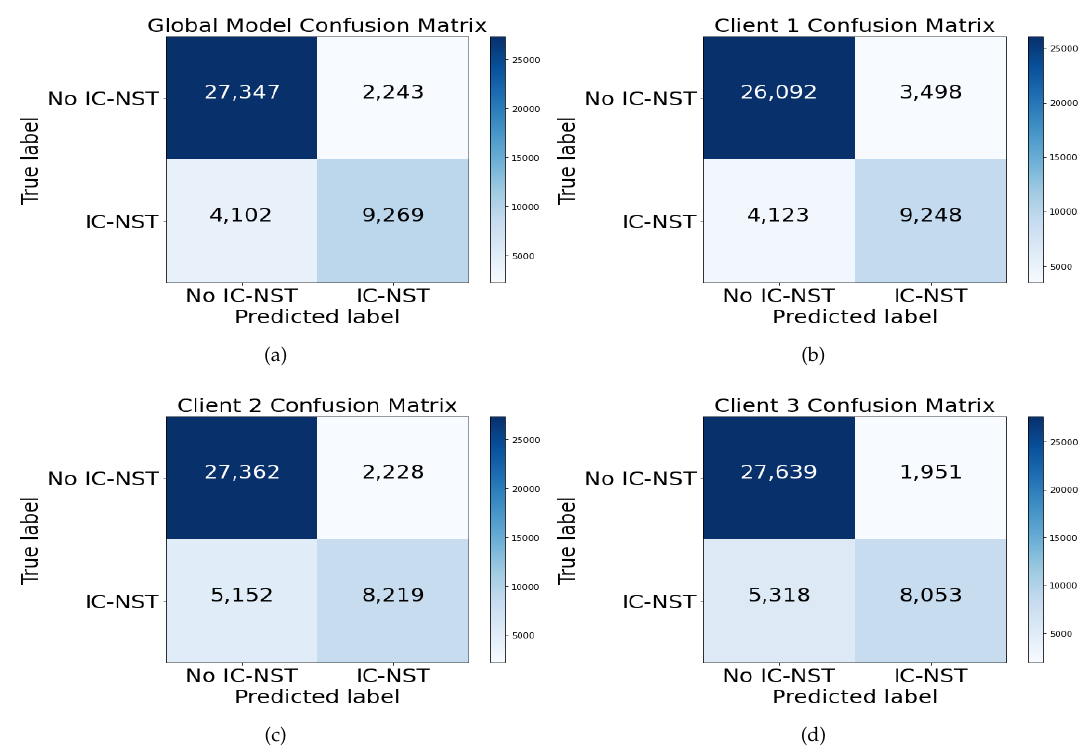
Figure 7. Confusion matrix for the ( a ) global model and the ( b ) client 1, ( c ) client 2, and ( d ) client 3 local models with the combined BHI test dataset and FL + ResNet50 +